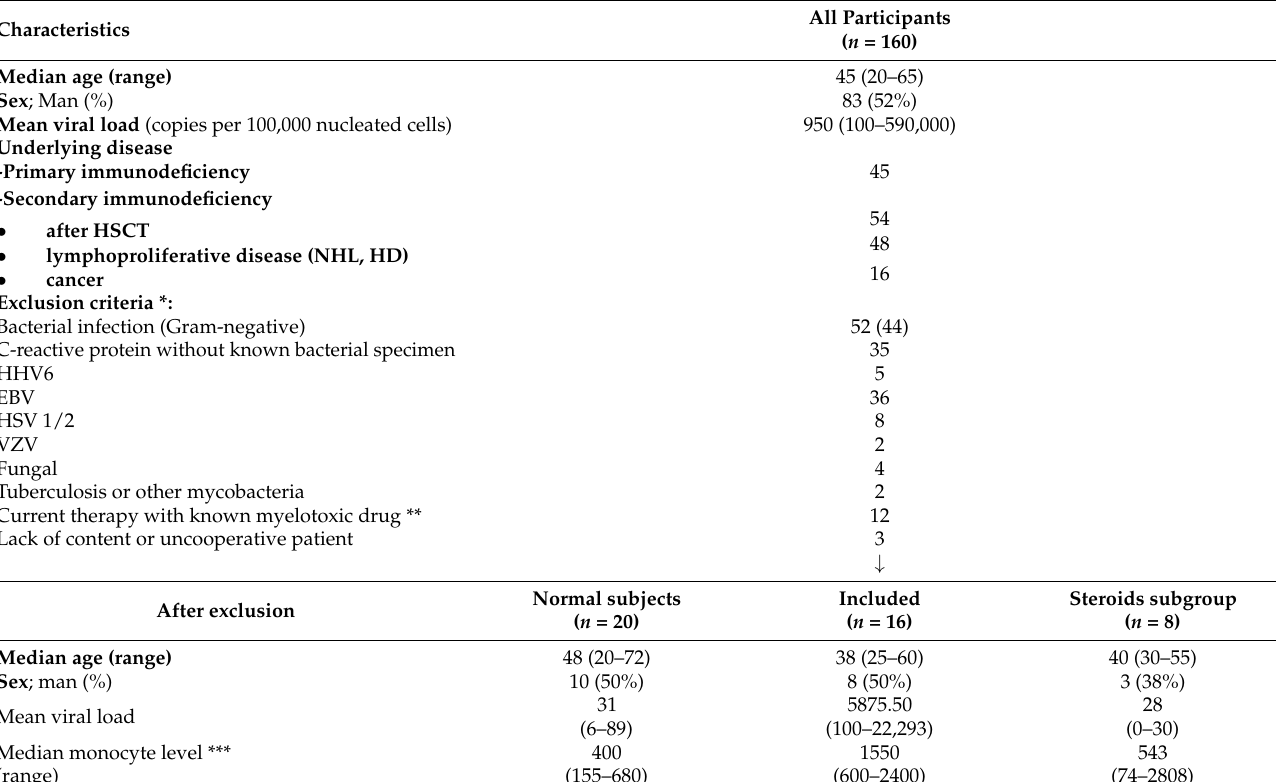
Table 2. Patients’